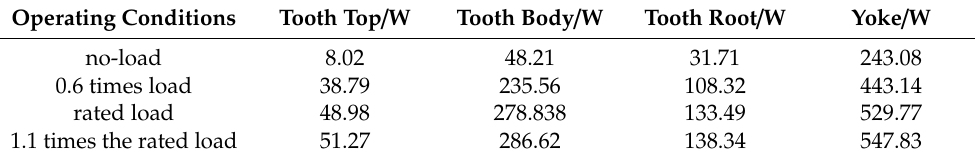
Table 5. Stator iron core loss distribution in each region under four kinds of operating conditions.